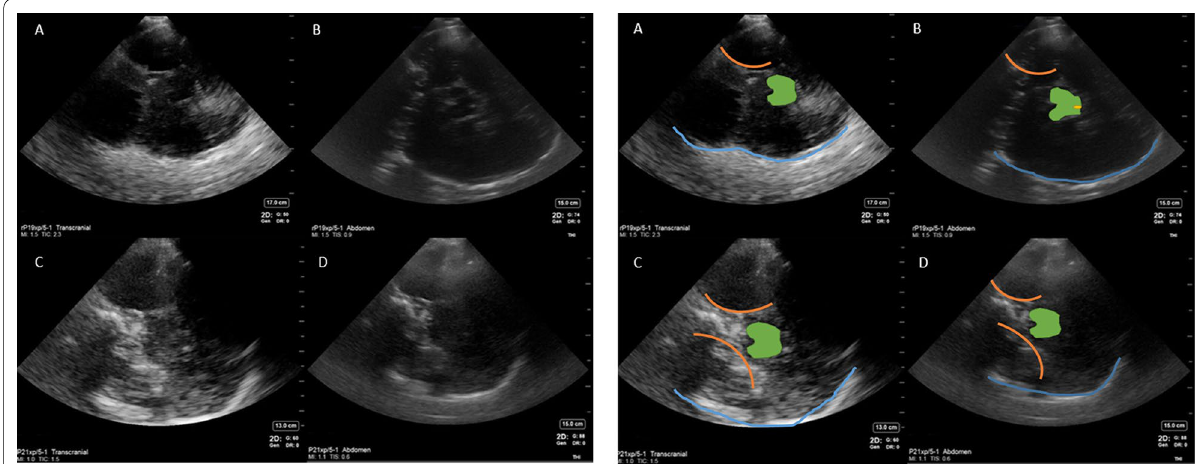
Fig. 1 Comparison of cranial B mode images on abdominal and transcranial preset with anatomical landmarks visible. Right Image Panel A , C are transcranial presets and Right Image Panel B , D are abdominal presets on same image. Marking on these images are labelled as followed: Blue line — opposite skull, orange line sphenoid wing and petrous part temporal bone, green midbrain, orange dot inside the midbrain—cerebral aqueduct. Left image shows unlabeled images of of both the transcranial presets ( A , C ) and abdominal presets ( B , D )